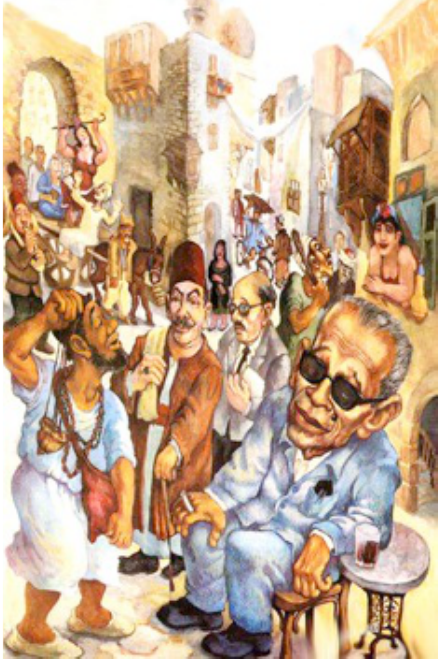
Figure (5) The artist presented a picture inspired by social life in Egypt, dealing with aspects of daily life, but with a quick caricature, and note that he showed the architectural identity of the place by drawing the women and the mosque and the houses that express the personality of the place.